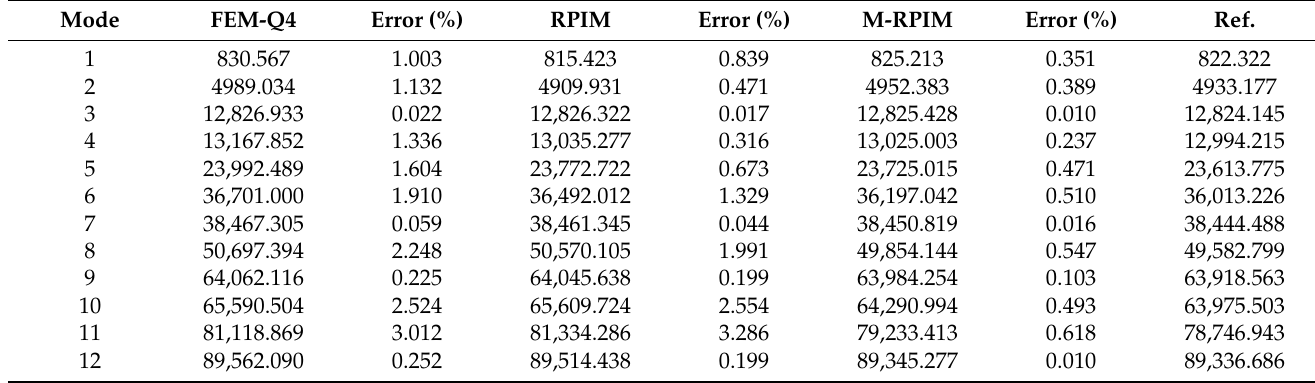
Table 1. The first twelve natural frequency solutions from the three numerical methods using the node arrangement pattern with average nodal space h = 2 mm.